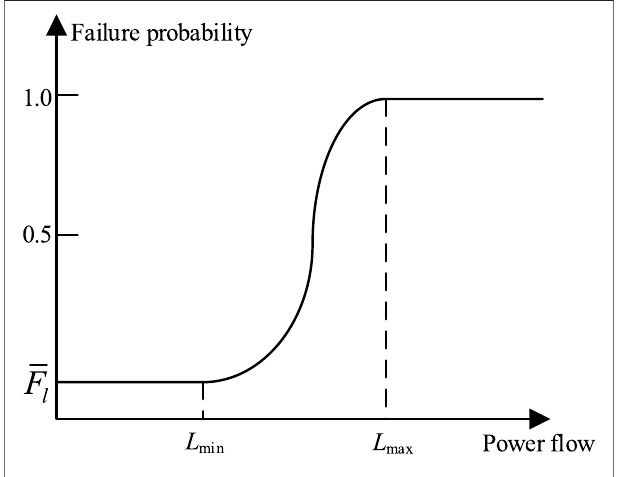
FIGURE 1 | Line failure probability curve with power fl ow.